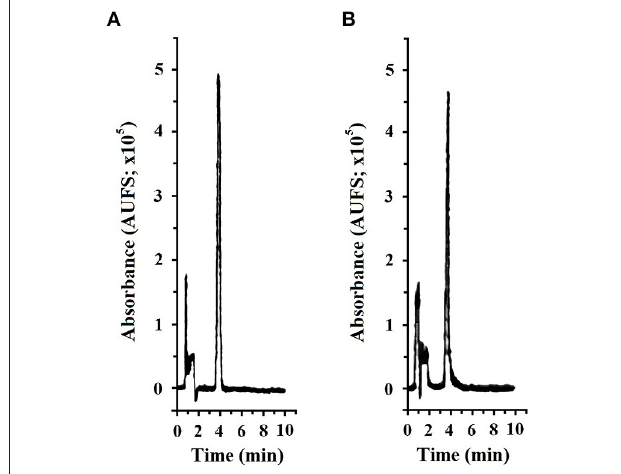
FIGURE 3 | Representative chromatogram (Teknokroma Analítica S.A., Barcelona 08173, Spain) of meloxicam (Sigma-Aldrich Química SA., Tres Cantos 28760, Madrid, Spain) at 1.2 µ g/ml concentration in methanol; retention time was 3.91min and AUC was 132,819 AUFS · min − 1 (A) and in nursehound shark ( Scyliorhinus stellaris ) plasma after processing using the methodology described by Montesinos et al. (22); retention time was